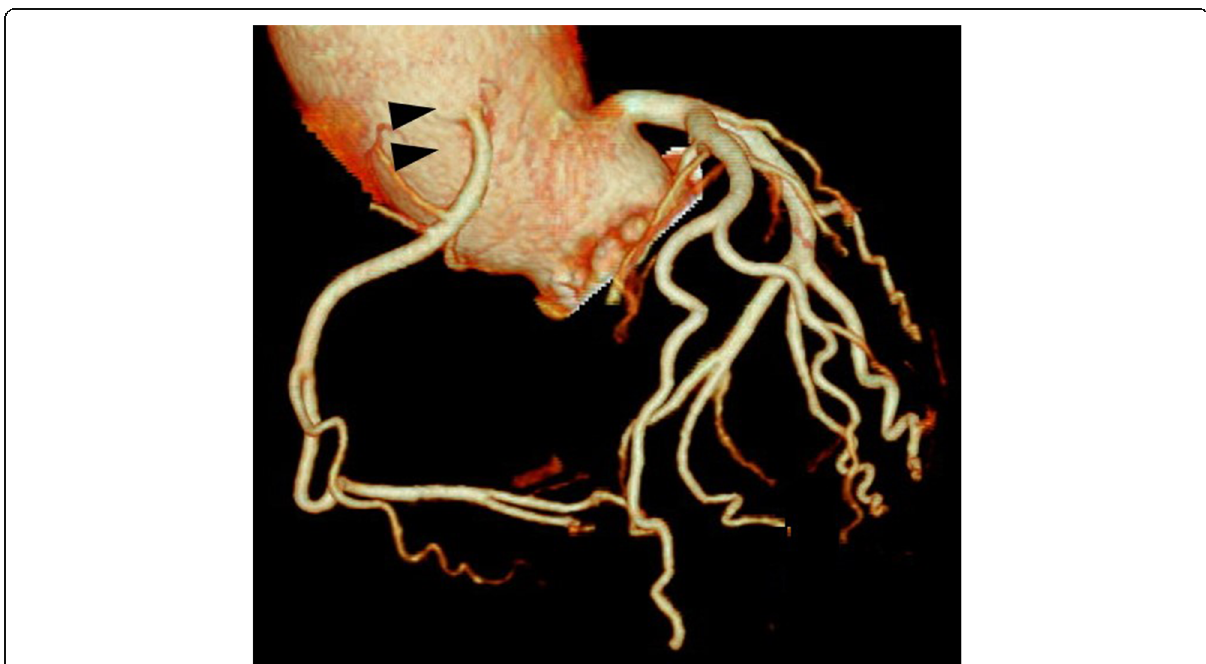
Fig. 2 Preoperative evaluation of the coronary artery by computed tomography. The right coronary artery has high-take-off from the aorta and stenosis noted at its origin (arrows)